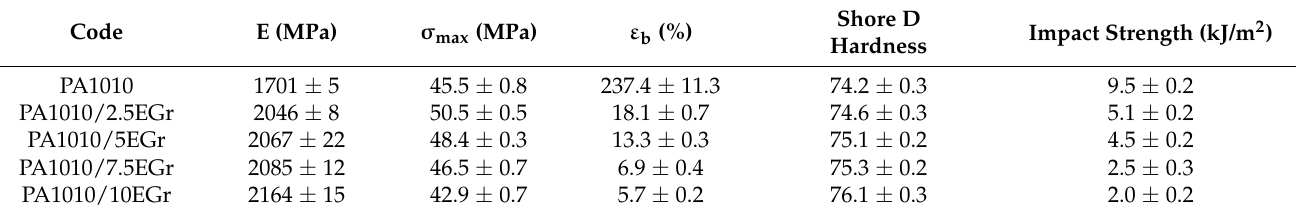
Table 2. Summary of mechanical properties of the PA1010/EGr composites in terms of: tensile modulus (E), maximum tensile strength ( σ max ), elongation at break ( ε b ), Shore D hardness and impact